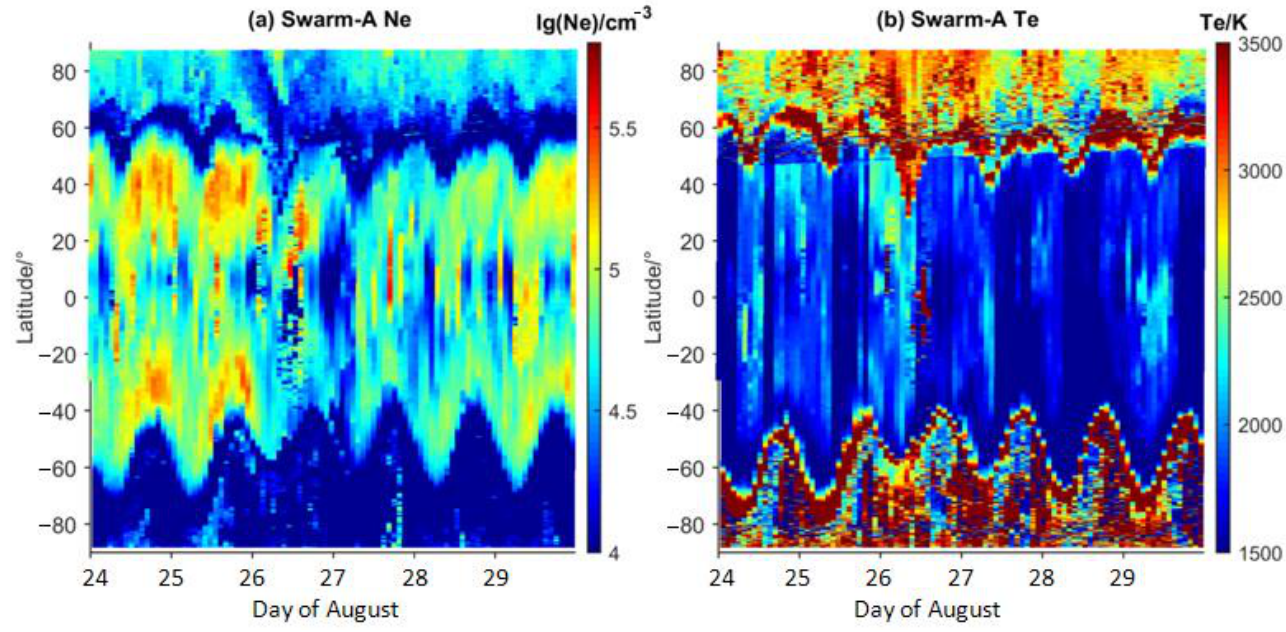
Figure 10. The electron density ( a ) and electron temperature ( b ) from Swarm-A in local nighttime during 24 to 29 August in 2018.